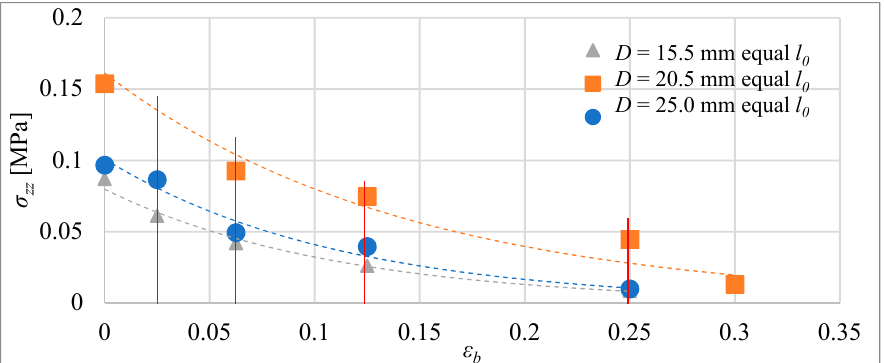
Figure 16. Blocking stress for tube actuators with equal initial length for 75 °C in the center.